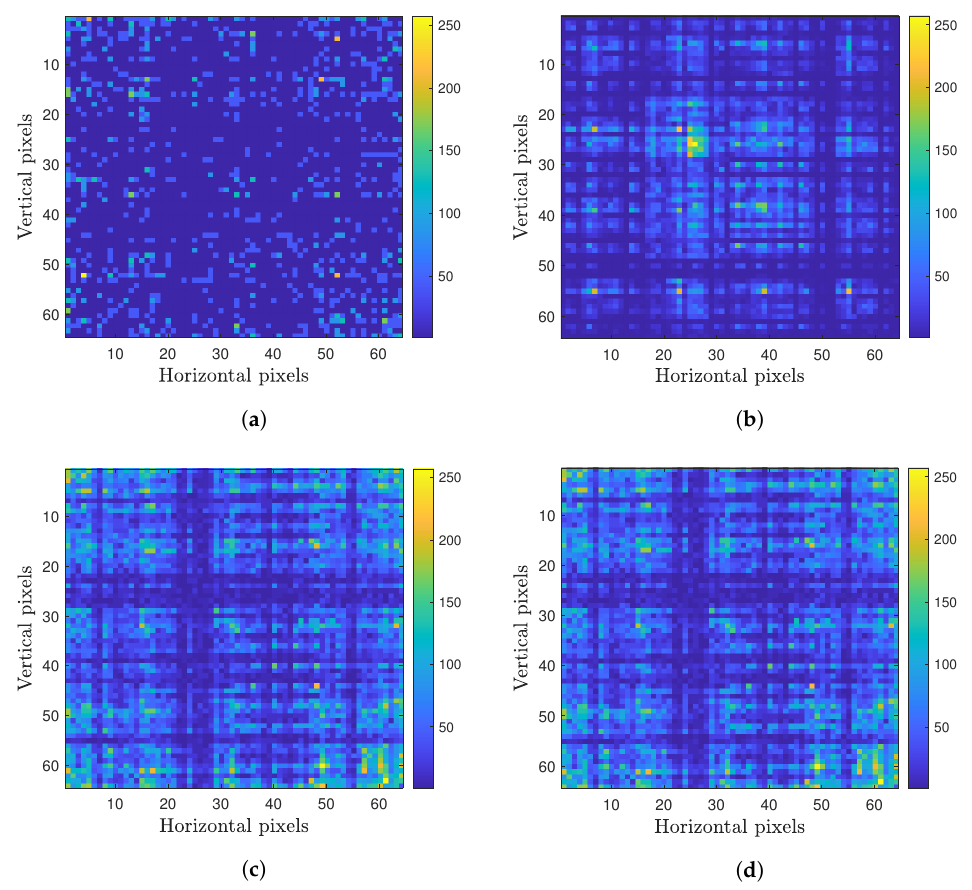
Figure 1. Examples of viral genomes in the form of images created by the process described in Section 2.2: ( a ) Paramecium bursaria Chlorella virus (NC_043234); ( b ) Gordonia phage Obliviate (NC_031237); ( c ) SARS-CoV-2 USA 2020 (MT251977); and ( d ) SARS-CoV-2 Wuhan-Hu-1